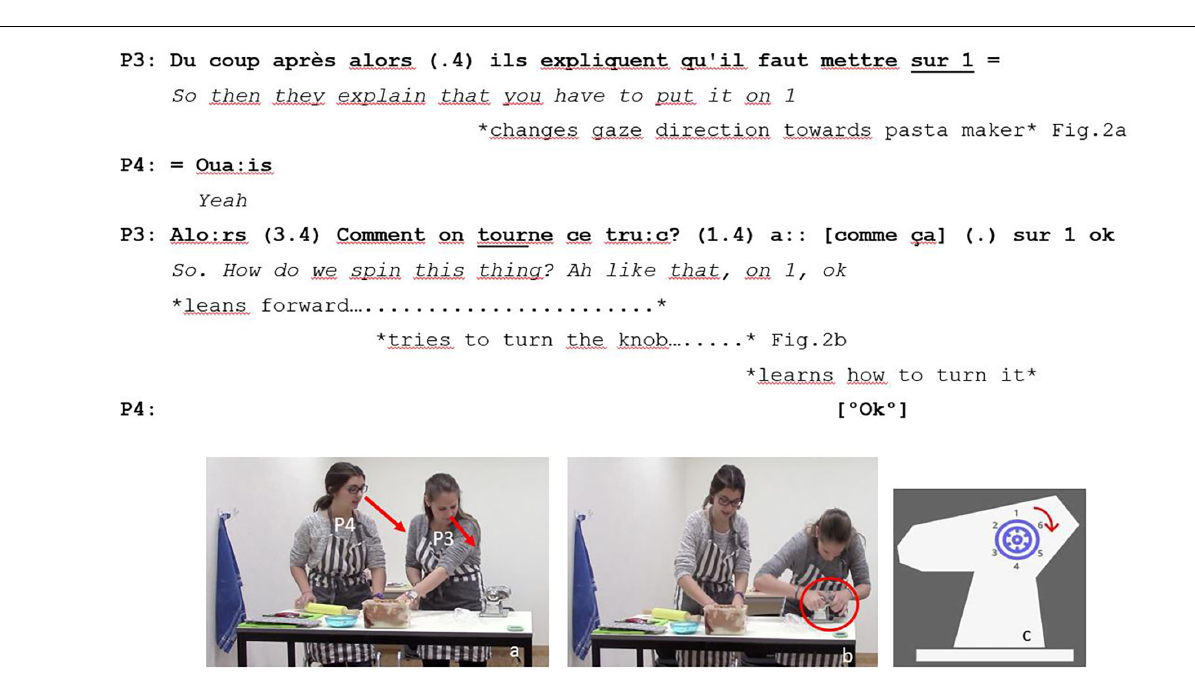
FIGURE 2 | Example of exploration questions while learning how to use